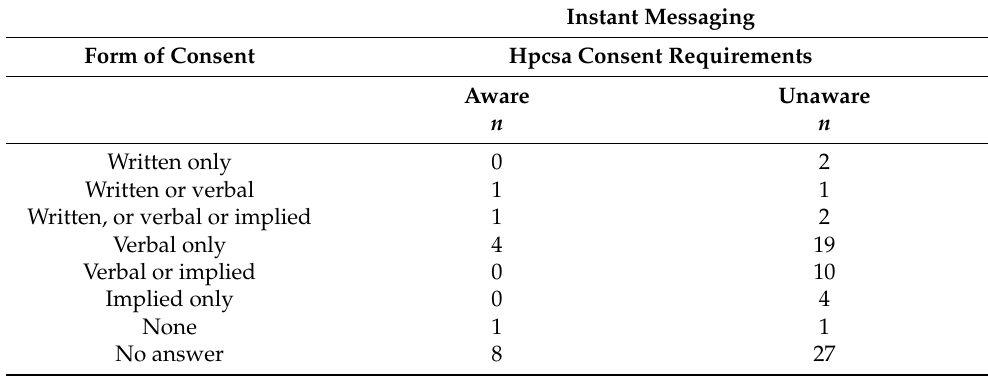
Table 4. Form of consent obtained by doctors for instant